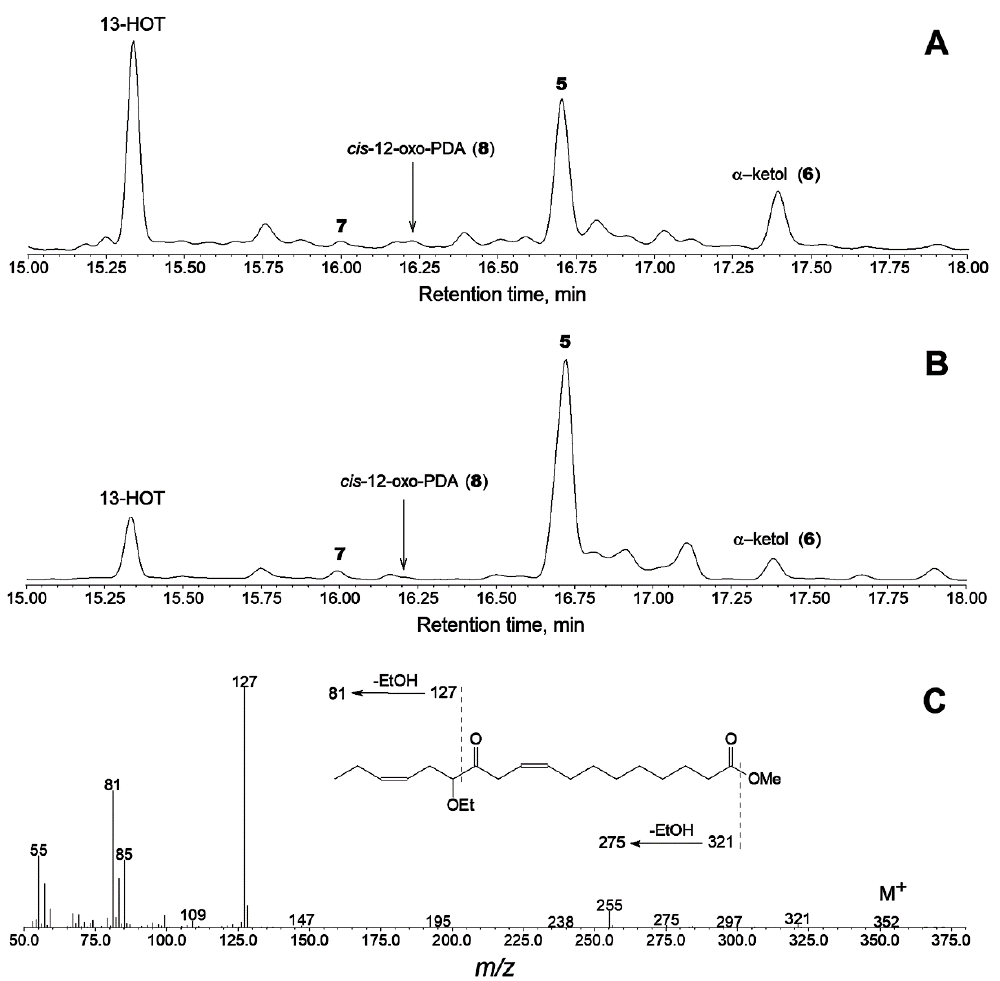
Figure 3. Products of ethanol trapping experiments after the brief incubations of 13-HPOT with LeAOS3 or ZmAOS. The total ion current GC–MS chromatograms of products (Me/TMS) of biphasic (hexane/water 40:1 by volume, 60 s, 0 °C) incubations of LeAOS3 ( A ) and ZmAOS ( B ) with 13-HPOT followed by (1) water freezing, (2) direct addition of ethanol excess to the hexane phase, (3) solvent evaporation, methylation and trimethylsilylation of products and (4) GC-MS analyses of product derivatives. ( C ) The electron impact mass spectrum of the trapping product 3 . Inset, the mass fragmentation scheme. The detailed experimental conditions are described in Materials and Methods.